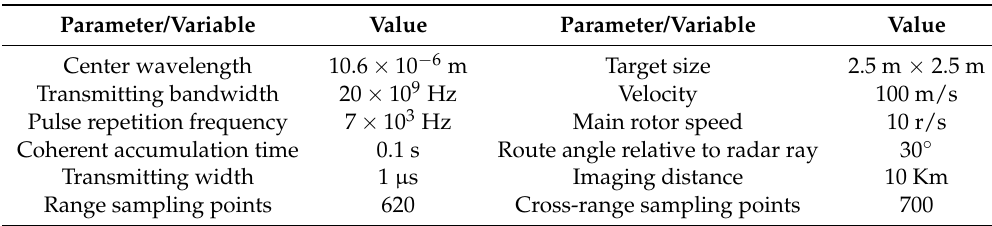
Table 1. Simulation